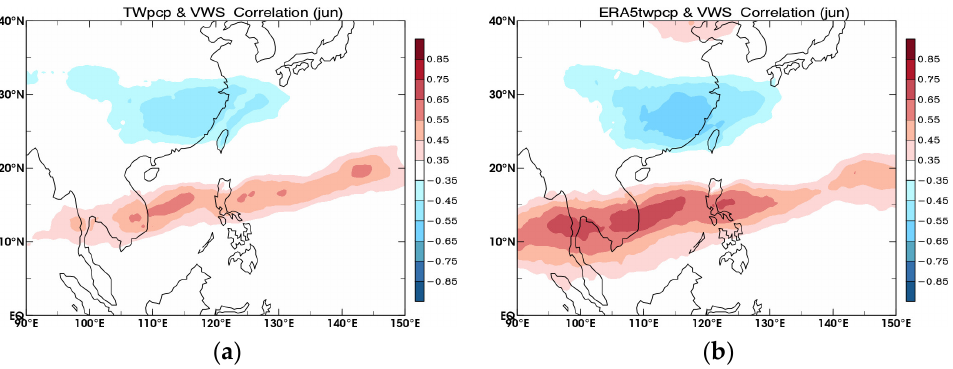
Figure 5. Correlation map between TWpcp ( a ), ERAtwpcp ( b ), and vertical wind shear (VWS). The shaded area shows that the correlation is significant at the 95% significant level.